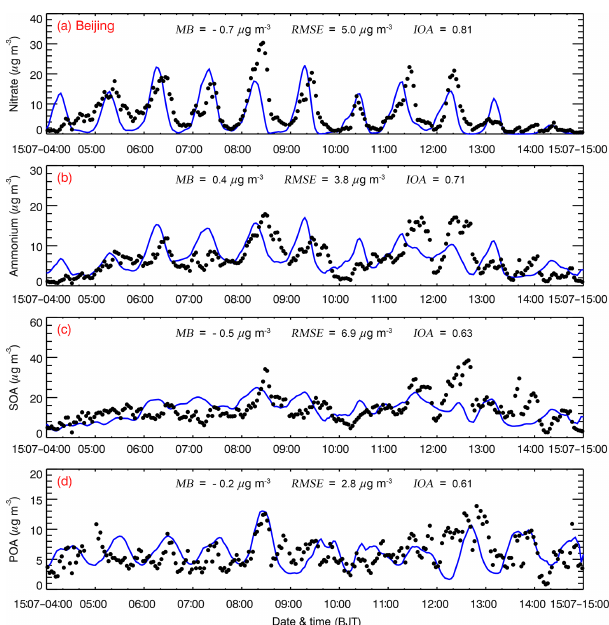
Figure 5. Comparison of observed (black dots) and simulated (blue line) diurnal profiles of hourly submicron (a) nitrate, (b) ammo- nium, (c) SOA, and (d) POA mass concentrations at the NCNST site in Beijing from 4 to 15 July 2015.